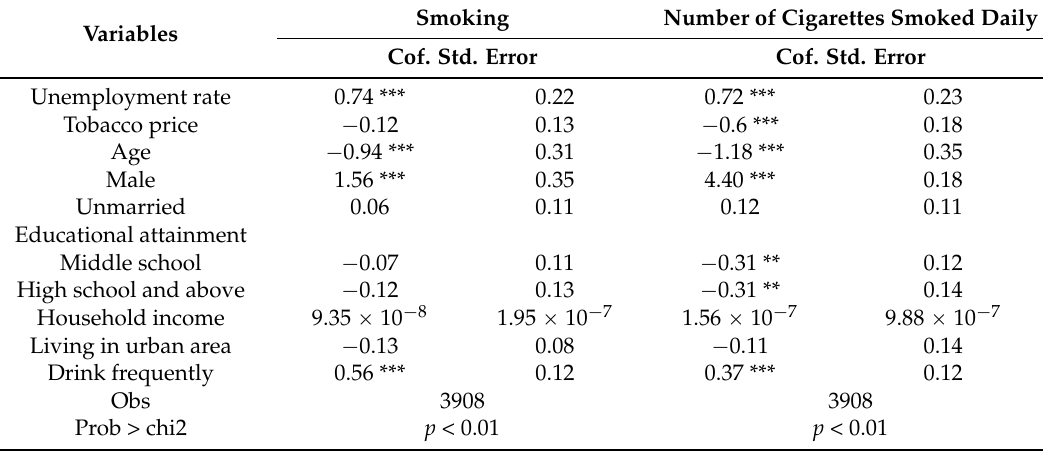
Table 4. Effects of unemployment rate on smoking behavior of employed individuals.